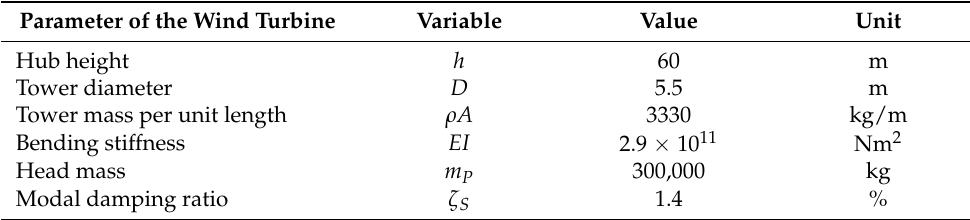
Table 1. Parameters chosen for the considered wind